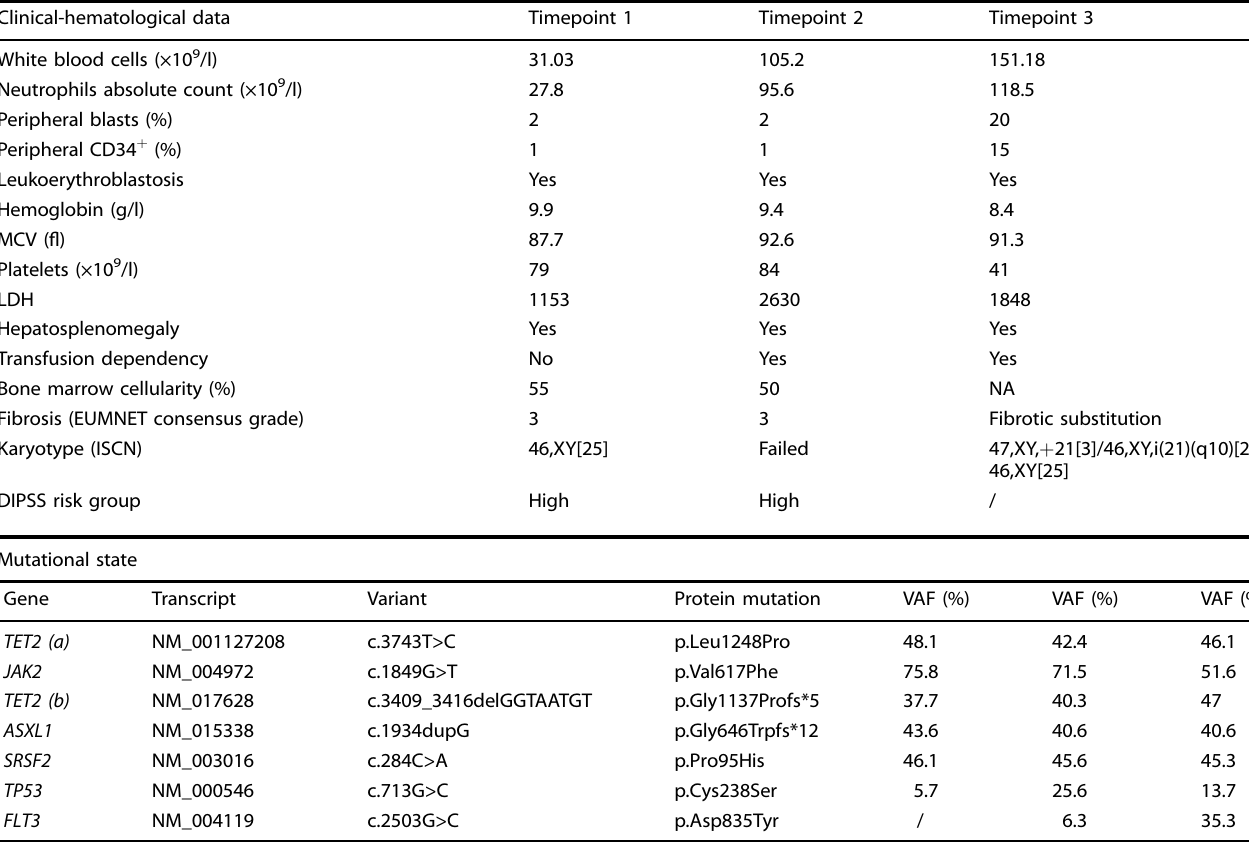
Table 1. Clinical data and mutational characterization of the patient in three different